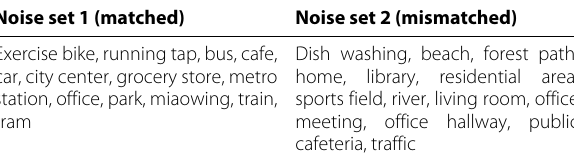
Noise set 1 (matched)